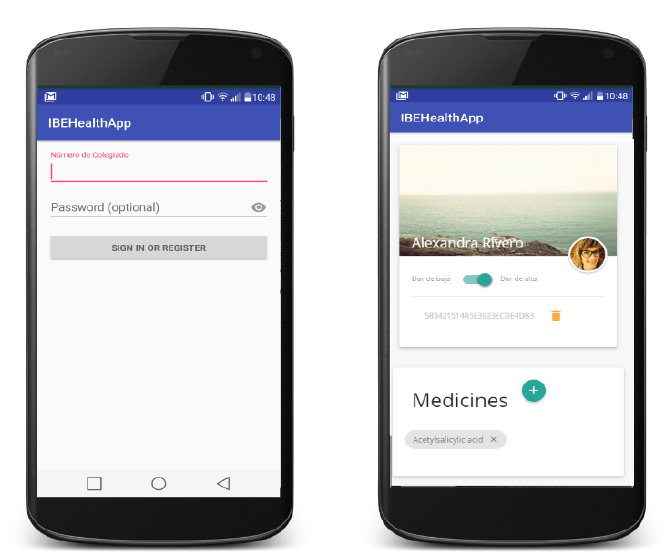
Figure 9. Mobile application. ( left ) View of registration; ( right ) View of patient